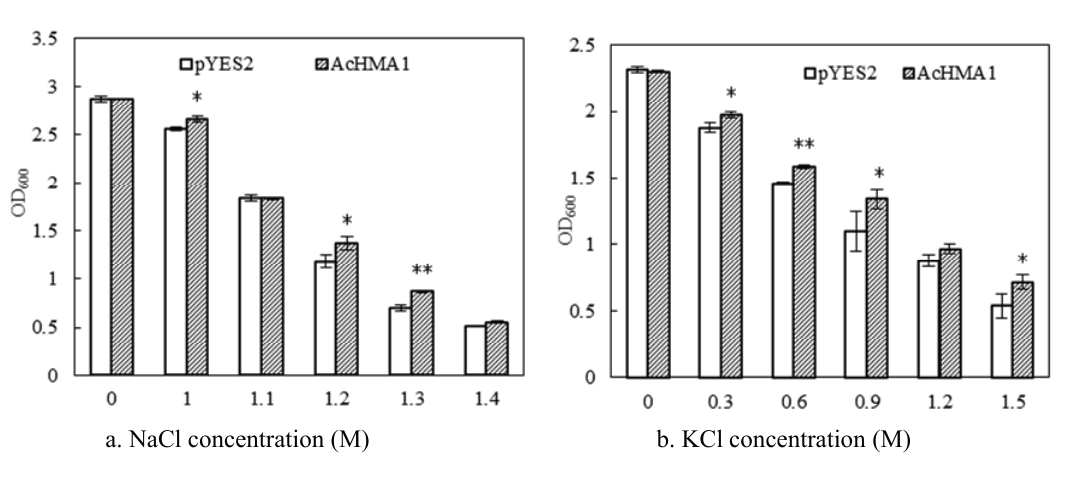
Figure 4. Stress response analysis of AcHMA1 overexpressing yeast cells. Growth of 1.4 M NaCl ( a ); 0.3, 0.6, 0.9, 1.2, 1.5 M KCl ( b ); or 1.1, 1.4, 1.7, 1.9 mM H